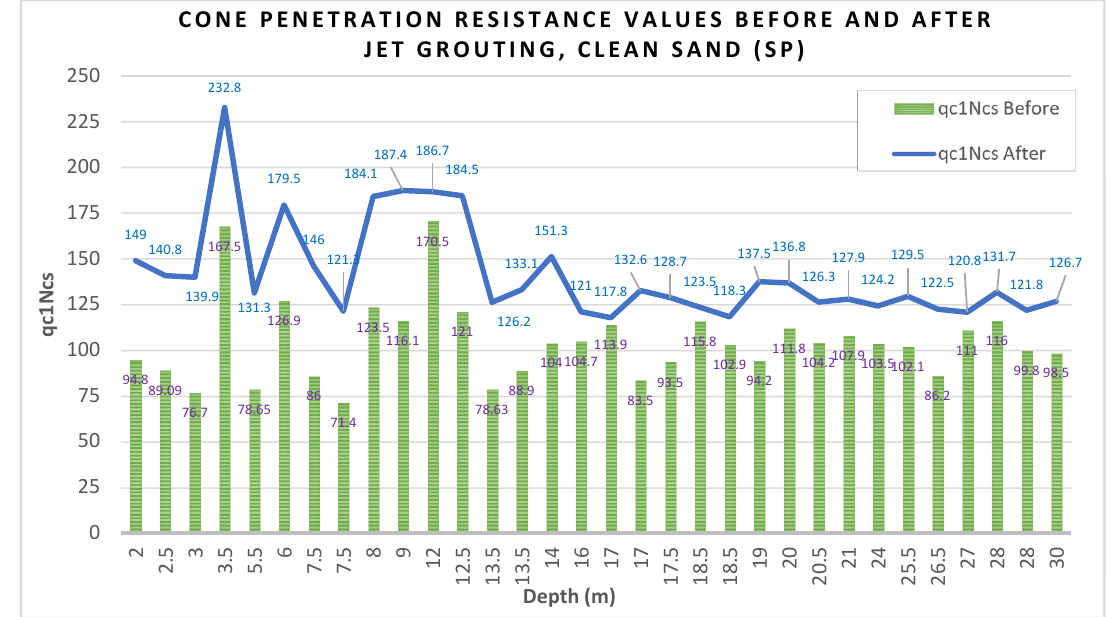
Figure 3. Cone penetration resistance values before and after jet grouting using micropiles in soil profile containing only poorly graded sand.